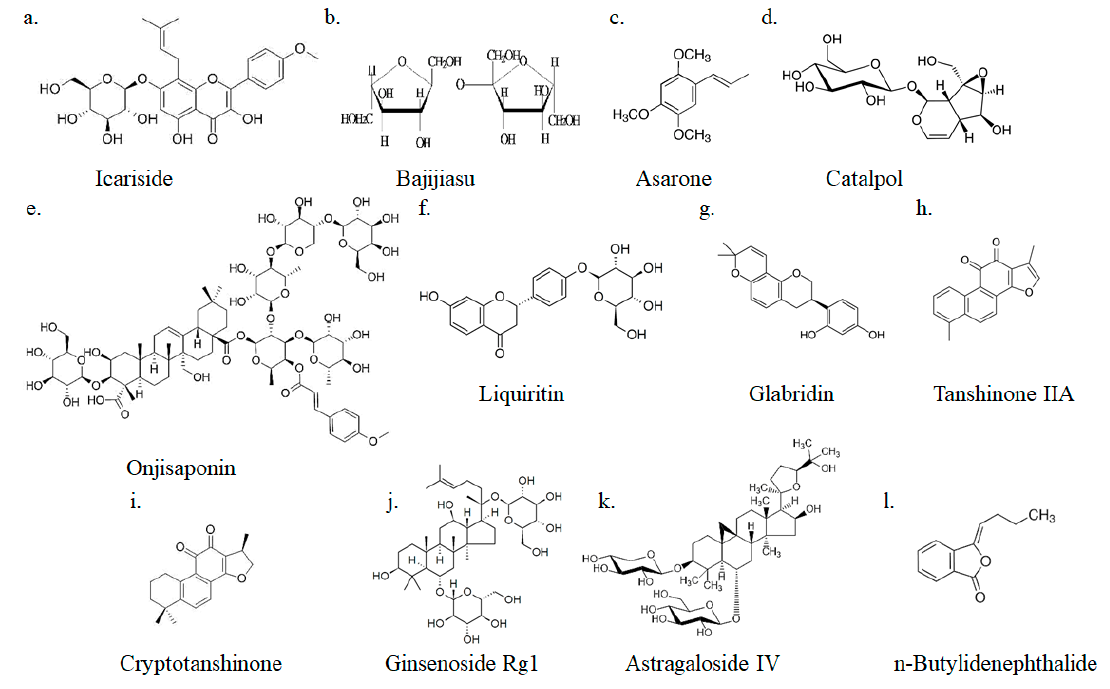
Figure 6. Small-molecule drug structures.